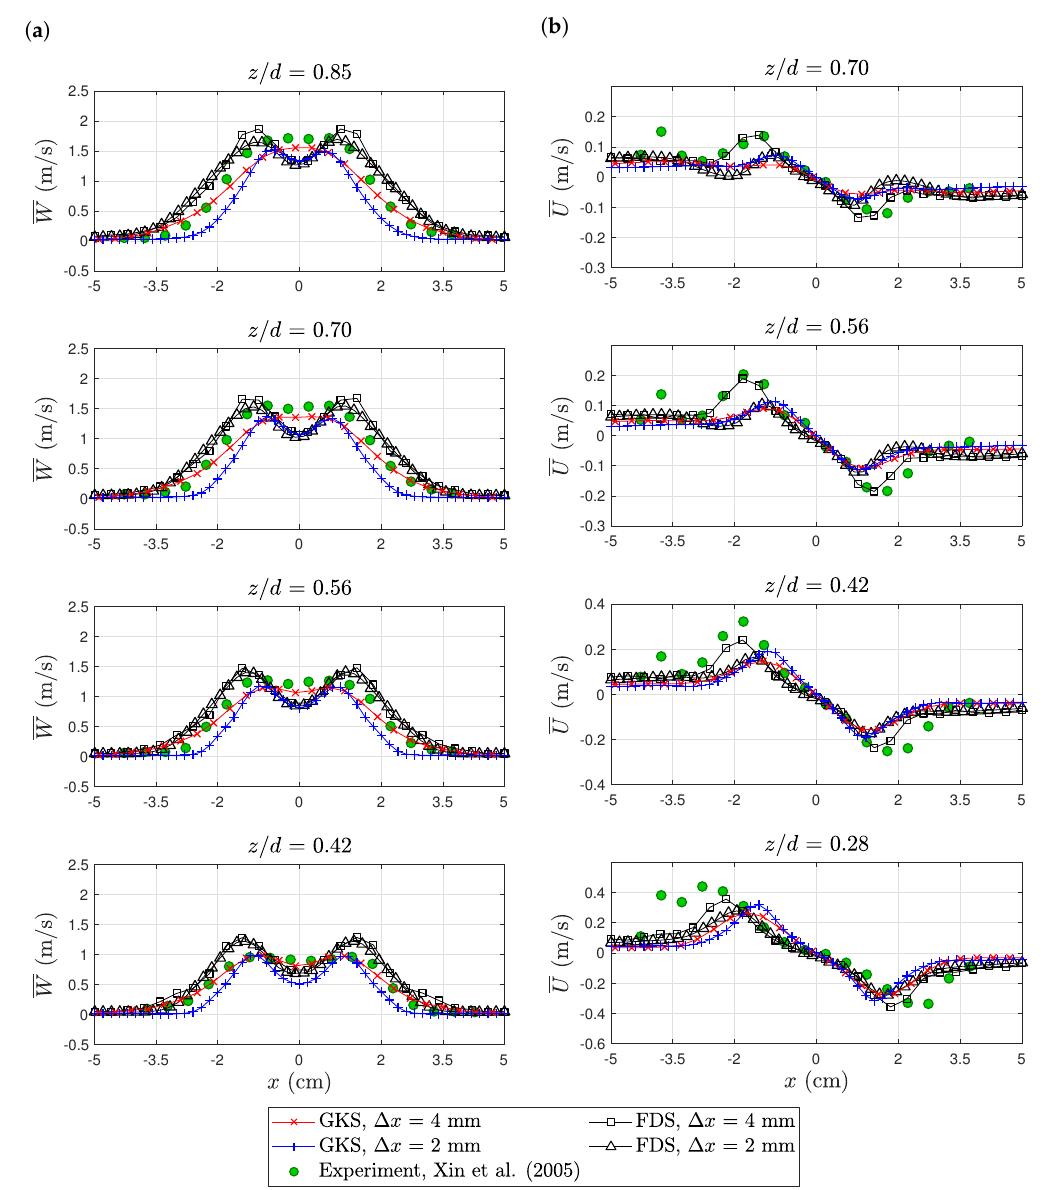
Figure 7. Purdue flame: profiles of axial (vertical) velocity ( a ) and radial (horizontal) velocity ( b ). The experimental data are available online at https://github.com/firemodels/exp/tree/master/